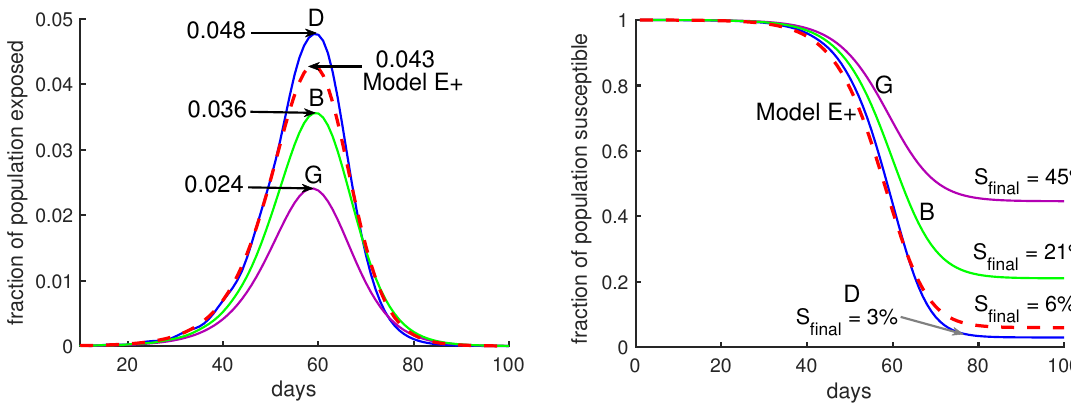
Figure 6. Moderate changes in Model J parameter values make a huge difference. Model J simulations are shown for three sets of parameters, B (green), D (blue), and G (purple). (See Table 1). In both panels the red dashed curve is for Model E+ with a constant contact rate β =